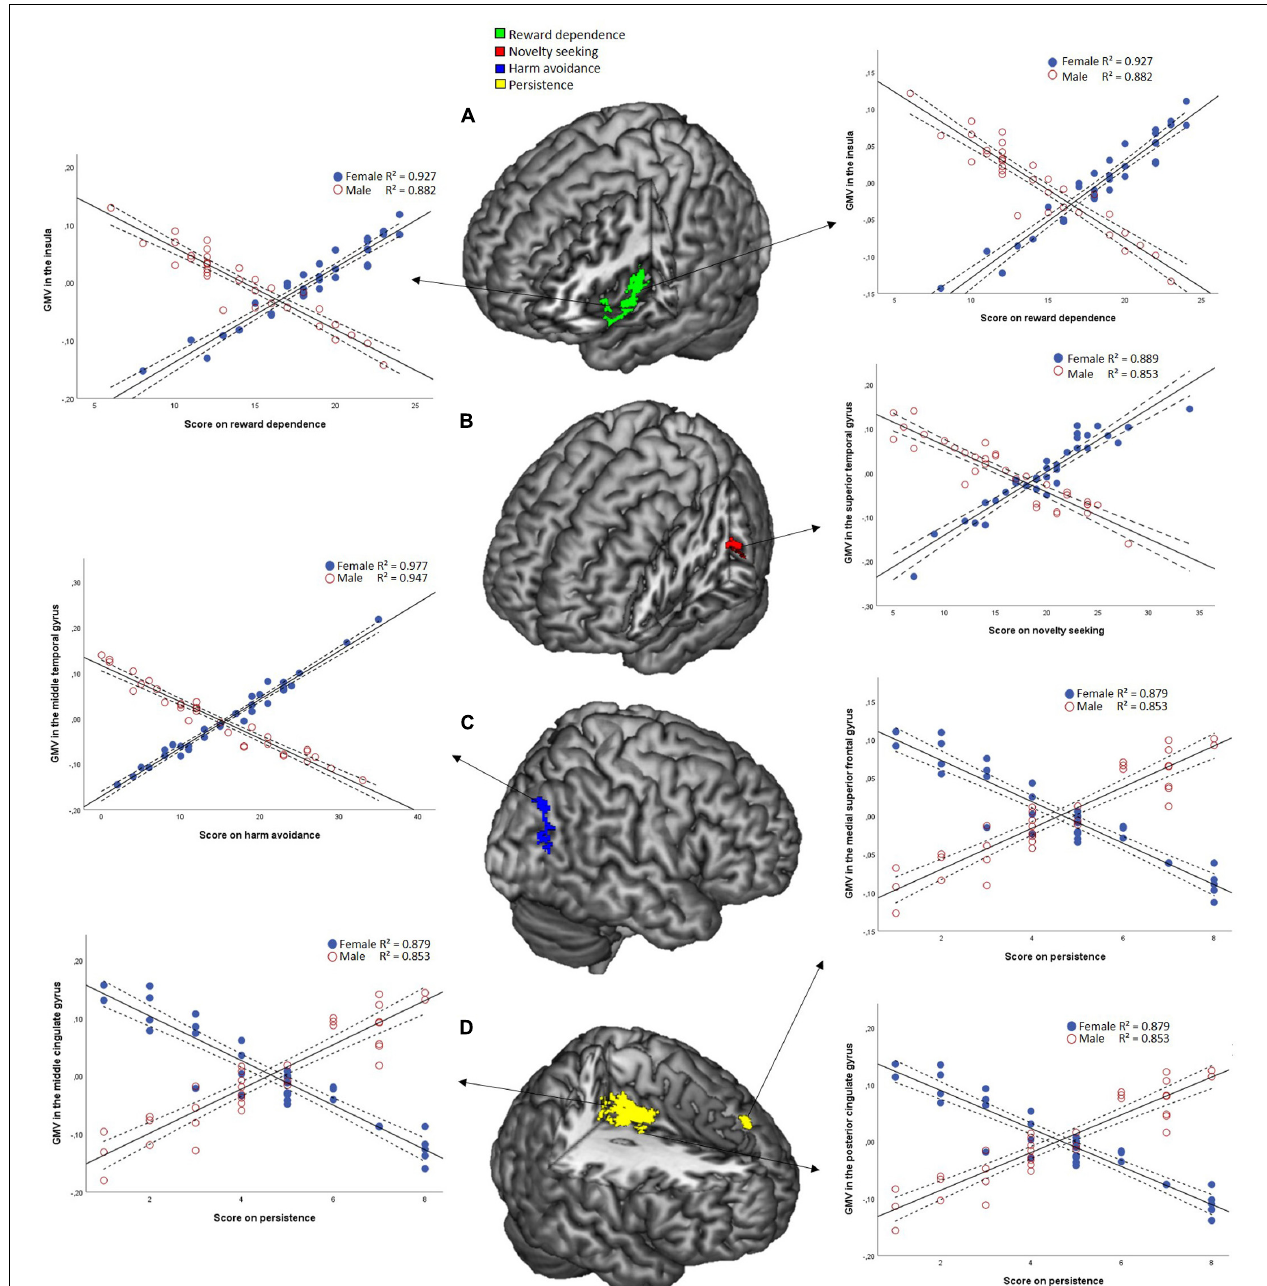
FIGURE 2 | Full factorial model results obtained at a statistical threshold of P height < 0.001 ( k = 10), combined with SVC, FWE-corrected at cluster level. The results are shown at a significance level of P = 0.05 and are overlaid on a canonical 3-dimensional–rendered MRI brain template with a cut-out. (A) In the middle a statistical map displaying the sex-temperament interaction effects on GMv for reward dependence. Left and right the partial correlation (Female: r = 0.963, Male: r = –0.939) between GMv in the insula as a function of reward dependence. (B) In the middle a statistical map displaying the sex- temperament interaction effects on GMv for novelty seeking. Right a scatterplot showing the partial correlation (Female: r = 0.943, Male: r = –0.925) between GMv in the superior temporal gyrus as a function of novelty seeking. (C) In the middle a statistical map displaying the sex-temperament interaction effects on GMv for harm avoidance. Left a scatterplot showing the partial correlation (Female: r = 0.989, Male: r = –0.973) between GMv in the middle temporal gyrus as a function of harm avoidance. (D) In the middle a statistical map displaying the sex-temperament interaction effects on GMv for persistence. Left a scatterplot showing the partial correlation (Female: r = –0.938, Male: r = 0.924) between GMv in the middle cingulate gyrus as a function of persistence. Right a scatterplot showing the partial correlation (Female: r = –0.938, Male: r = 0.924) between GMv in the medial superior frontal gyrus as a function of persistence and the partial correlation (Female: r = –0.938, Male: r = 0.924) between GMv in the posterior cingulate gyrus as a function of